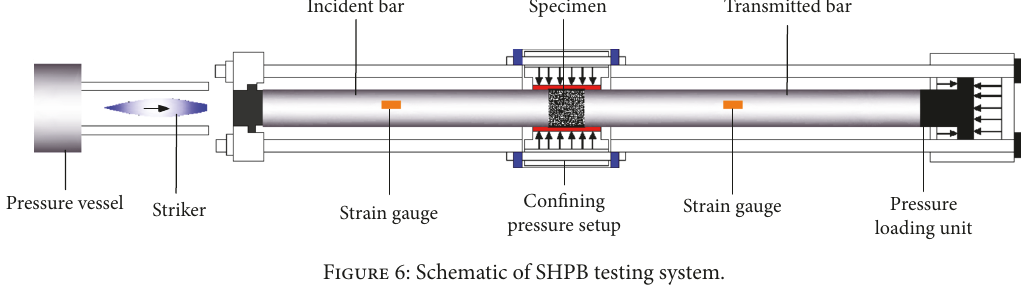
Figure 6: Schematic of SHPB testing system.